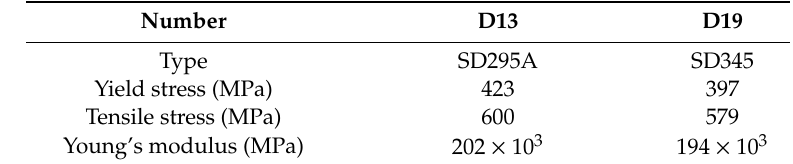
Table 3. Steel Table 3. Steel properties.